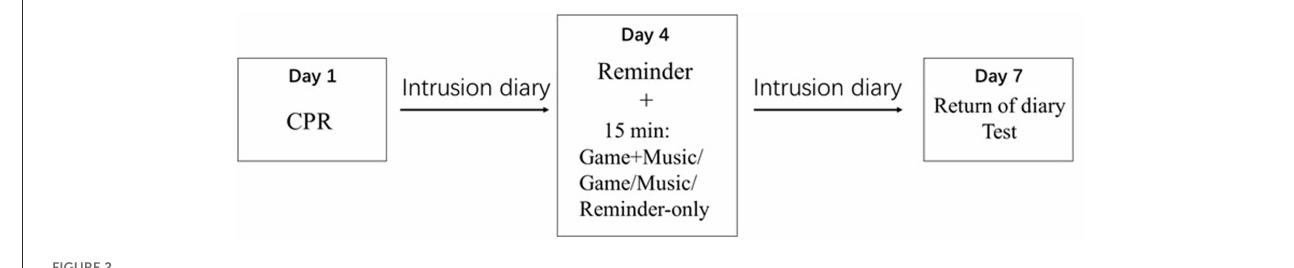
FIGURE2 General study